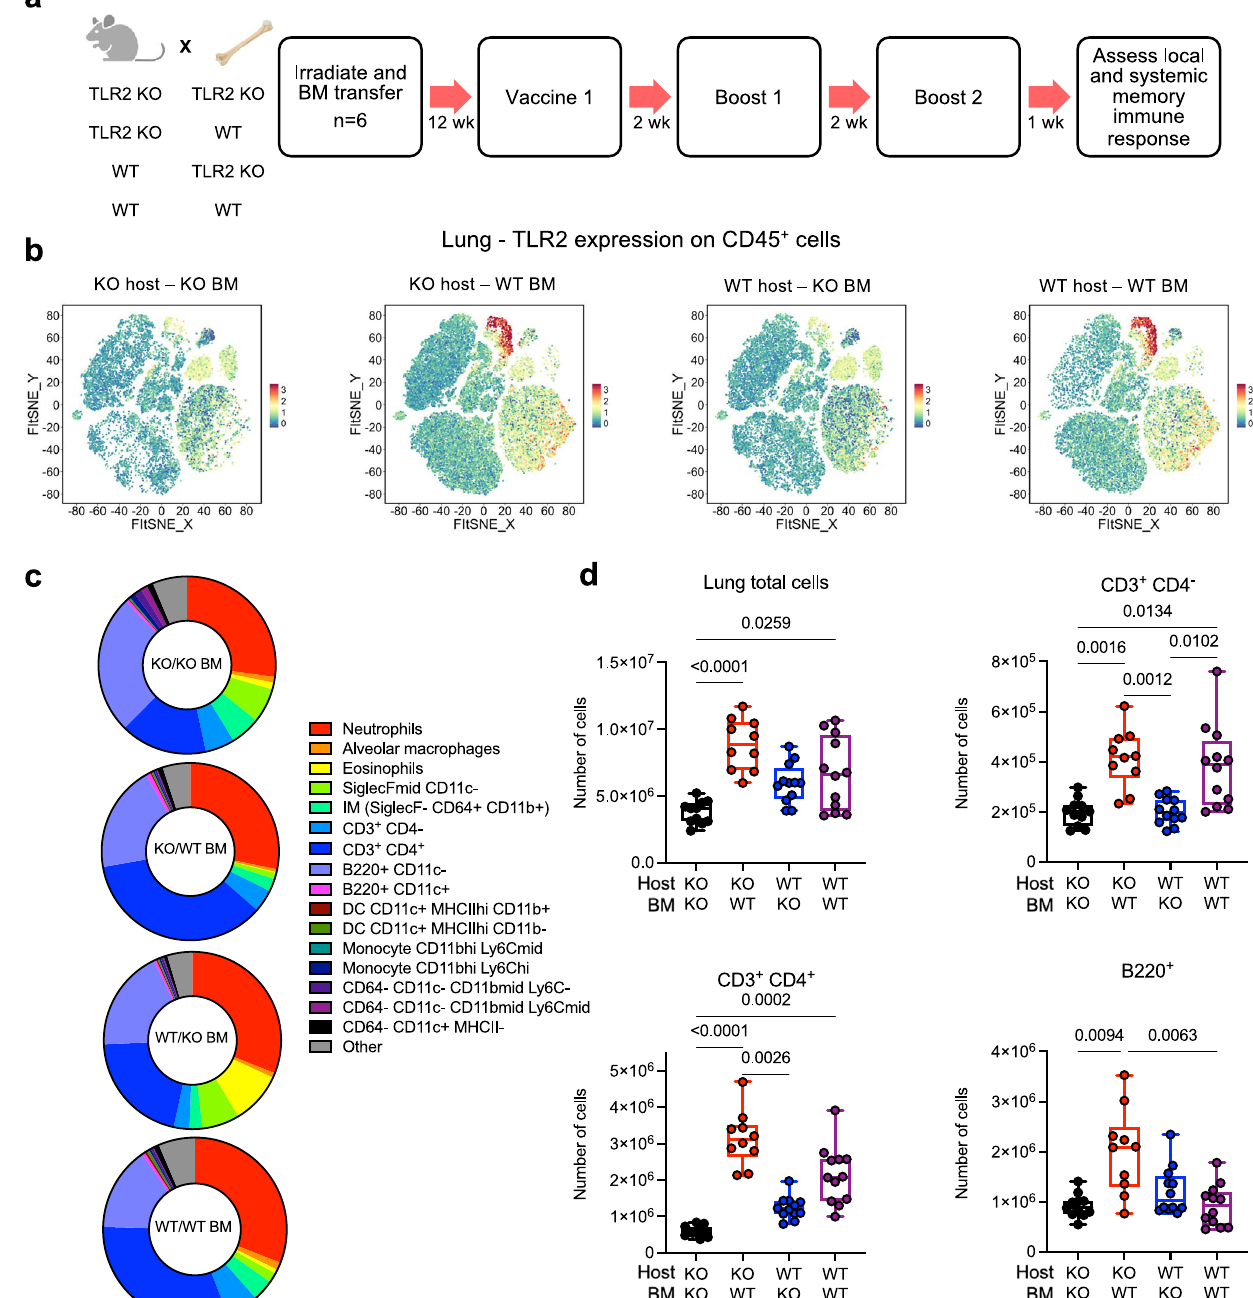
Fig. 6 | TLR2 expression by the hematopoietic lineage is required for optimal T-cell responses in the lung following mucosal vaccination and boosting with Pam 2 Cys Spike.a Experimental outline (week; wk). Tlr2 − / − (KO) or wild type (WT) mice were irradiated then received transfer of Tlr2 − / − or WT bone marrow (BM) cells i.v. Mice were rested for 12 weeks to allow hematopoietic reconstitution and replacement, then immunized with Pam 2 Cys Spike intra-nasally (i.n) three times, two weeks apart. Immune responses in the lungs were characterized at one week post fi nal vaccination. b To verify bone marrow replacement, unsupervised clus- tering of lung CD45 + cells was performed on fl ow cytometry data and relative